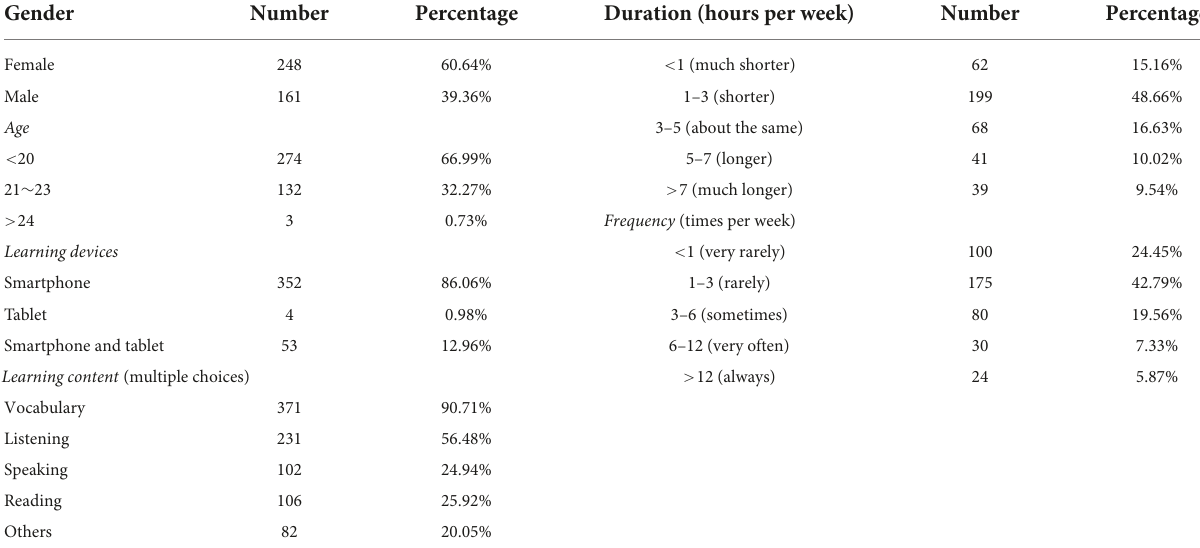
TABLE 1 Demographic information of the participants.